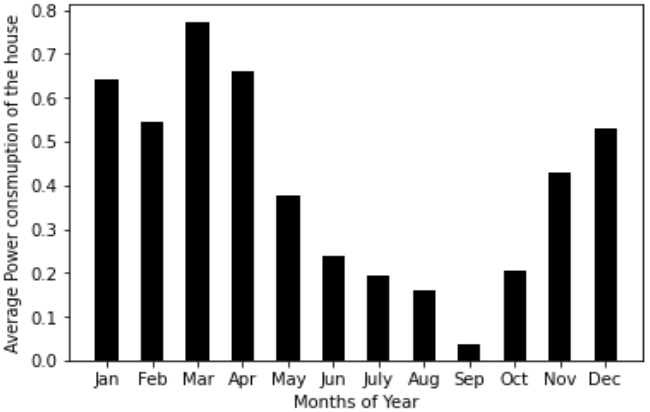
Figure 3. Load profile of the house under consideration.